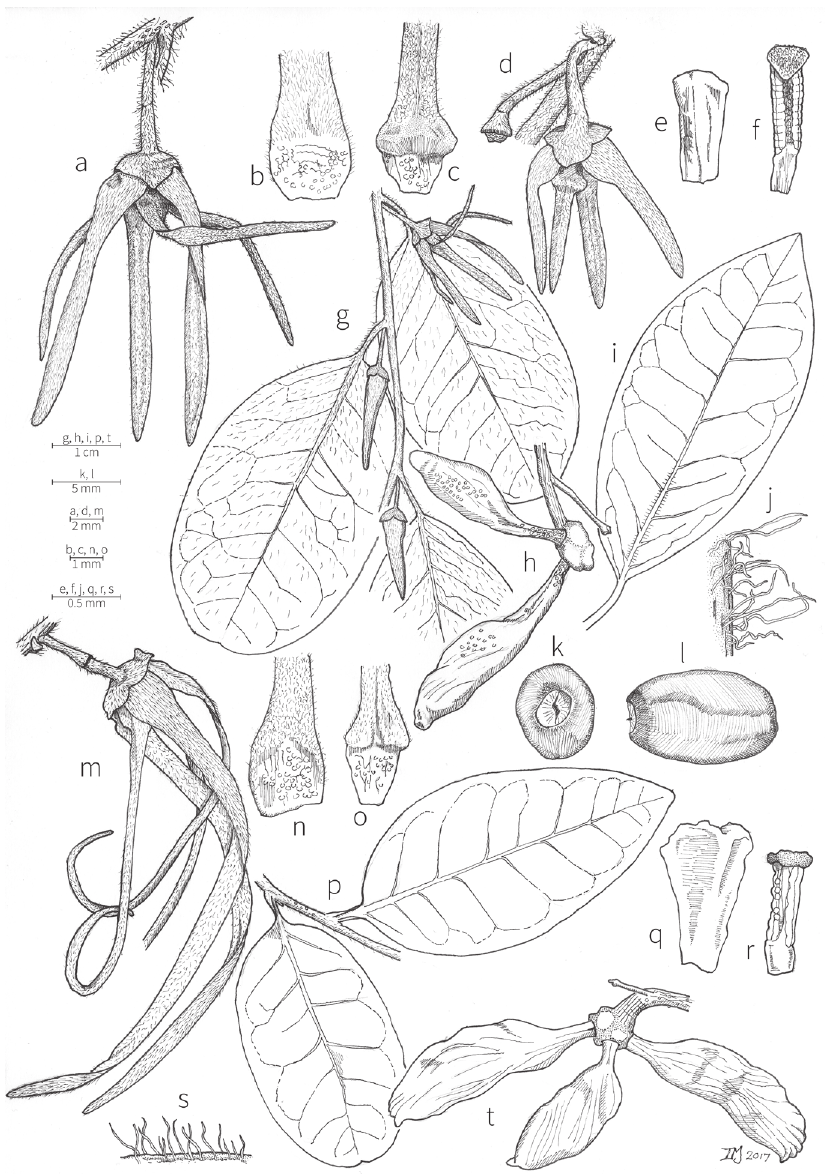
Figure 25. Xylopia gracilipes and X. torrei . A–L X. gracilipes A Flower, side view B Base of outer petal, adaxial view C Base of inner petal, adaxial view D Flower, side view E Outer staminode, abaxial view F Fertile stamen, abaxial view G Habit H Fruit, side view I Leaf from same specimen as G J Close-up of twig pubescence K Seed, view of micropylar end L Seed, side view M–T X. torrei M Flower, side view N Base of outer petal, adaxial view O Base of inner petal, adaxial view P Habit Q Outer staminode, abaxial view R Fertile stamen, abaxial view S Close-up of twig pubescence T Fruit, side view. A–C, E–J from Torre & Correia 16681 (WAG) D from Renny 253 (PRE) K, L from Fidalgo de Carvalho 685 (MO) M–T from Goyder 5037 ( K ). Figure originally published in Burrows et al. (2018), reproduced with